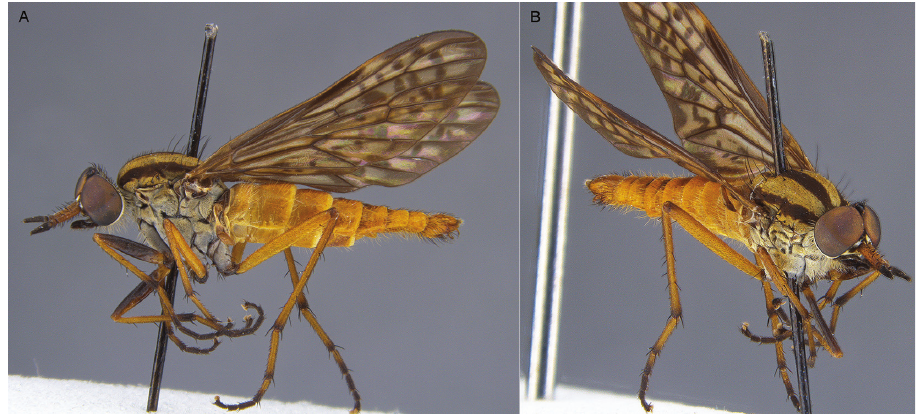
Figure 21. Zelothrix warrumbungles sp. n.: A Male lateral view B same, oblique view.